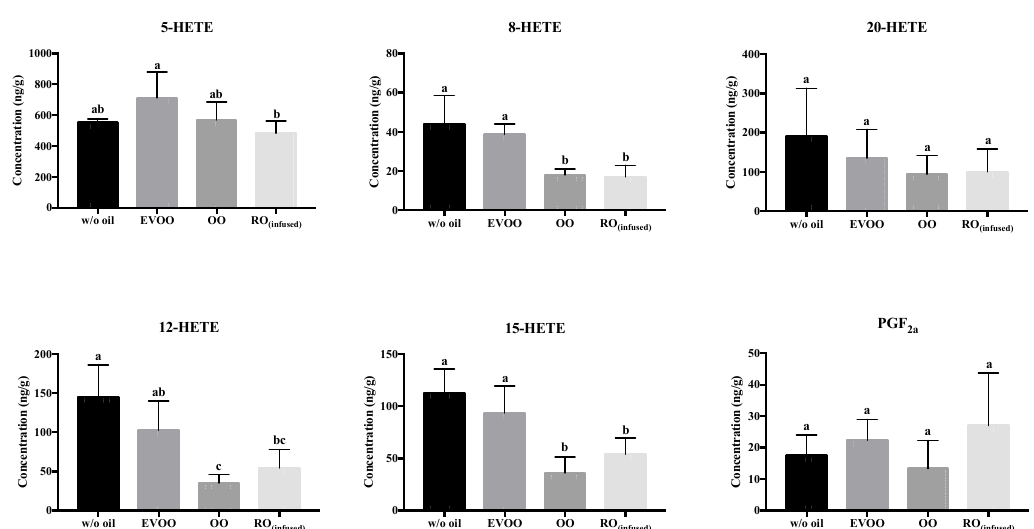
Figure 5. Concentration of enzymatic oxidized products of ARA in pan-fried salmon samples (ng of analytes per g of salmon meat). Data are presented in mean ± S.D. ( n = 6). w/o oil: without oil; EVOO: extra virgin olive oil; OO: olive oil; RO (infused) : rosemary-infused oil. Columns sharing different alphabets are significantly different at least p < 0.05.